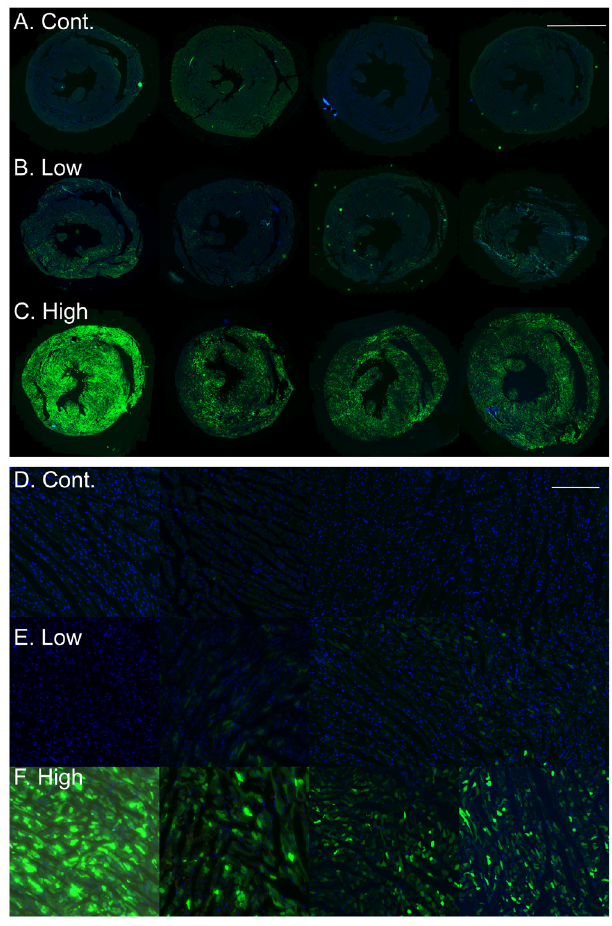
Figure 3. High cardiac expression of GFP in adult rats injected with AAV9-cTnT-eGFP. A – C . Low magnification images of cardiac sections of rats with GFP fluorescence (green) and DAPI nuclear stain (blue) showing no green GFP fluorescence in control saline injected rats ( A ), few transduced GFP positive cardiomyocytes in the low dose AAV9-cTnT-eGFP injected rats ( B ), and robust high GFP expression in the high dose AAV9-cTnT-eGFP injected rats ( C ). Each image was taken from a different rat. Bar = 5 mm. D – F . High magnification images from the same rats shown in A – C , showing no green GFP fluorescence in control saline injected rats ( D ), few transduced GFP positive cardiomyocytes in the low dose AAV9-cTnT-eGFP injected rats ( E ), and robust high GFP expression in the high dose AAV9-cTnT-eGFP injected rats ( F ). Each image was taken from a different rat. Bar = 200